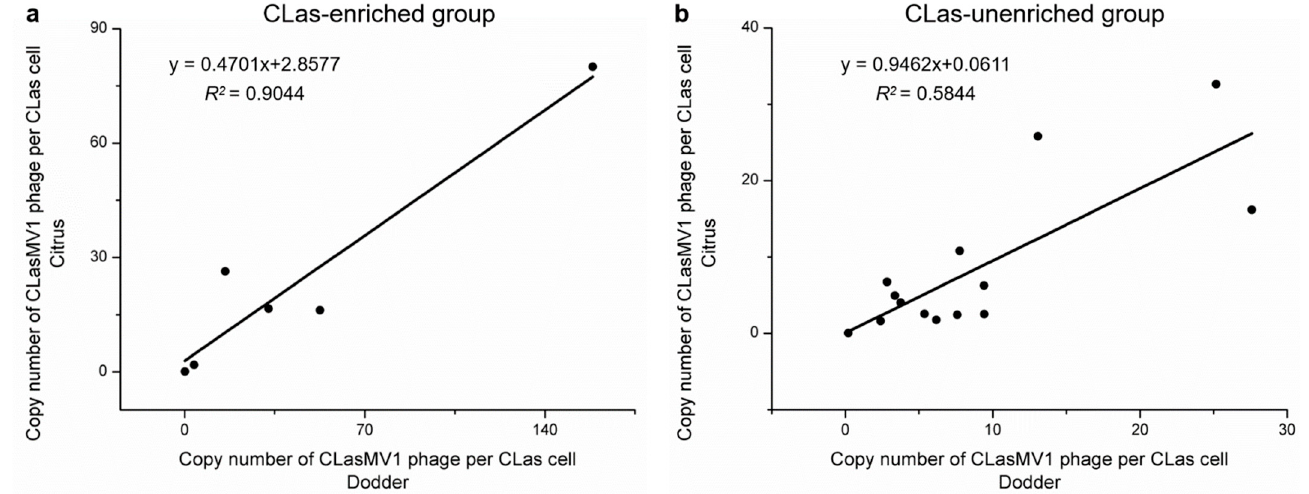
Figure 1. Linear trend line analysis of CLasMV1 phage density in dodder and in the parasitizing citrus branch. ( a ) The CLas-enriched group; ( b ) CLas-unenriched group.